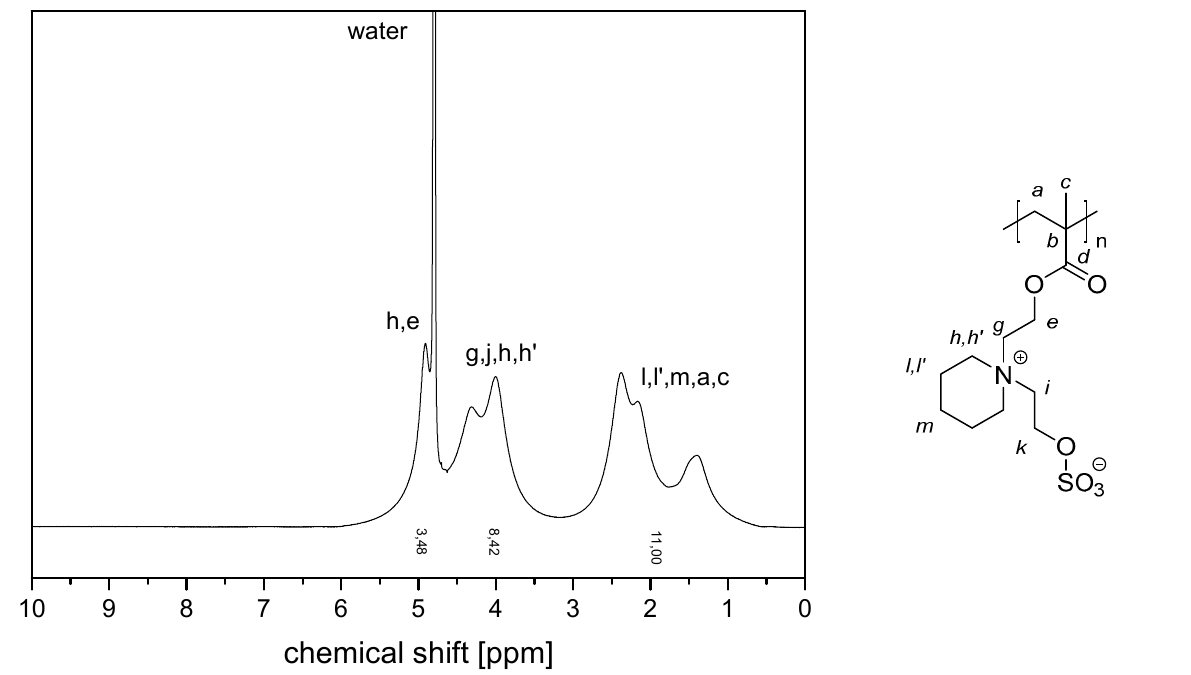
Figure A15. 1 H NMR-spectrum of polymer P − 4c in D 2 O saturated with NaCl.